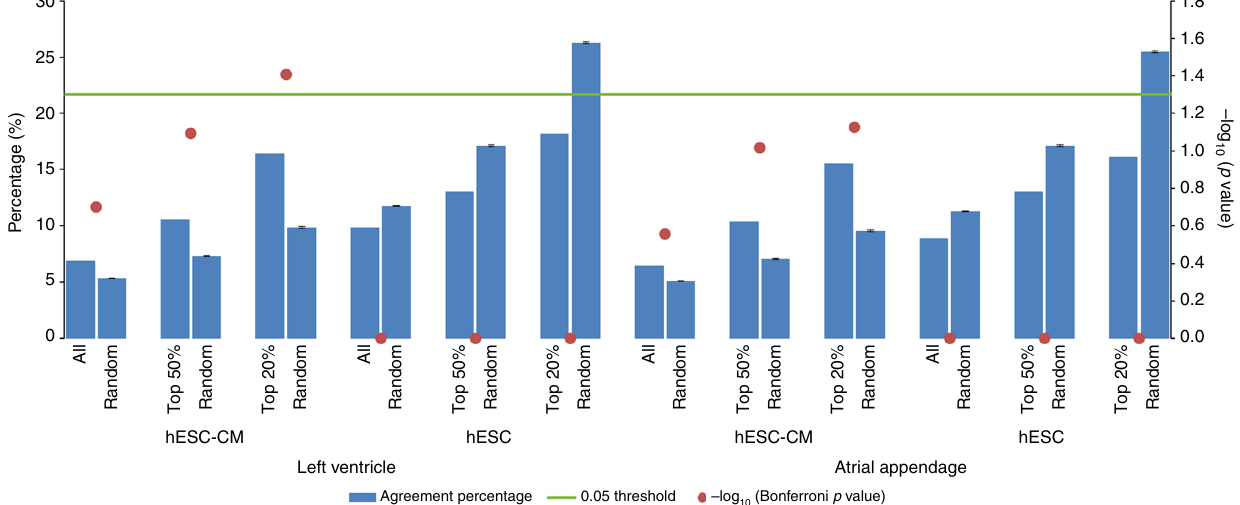
Fig. 3 Agreement percentages of eQTL – gene and PIR – gene pairs. Agreement percentages of eQTL – gene (GTEx) and PIR – gene pairs (either cPIRs or hESC PIRs), fi ltered to the top 20% and 50% of read counts, in the left ventricle and atrial appendage. Results obtained with randomised PIRs (1000 permutations) are shown as controls. The p values were generated from permutation tests performed to compare observed vs. randomised PIRs and corrected for multiple testing using Bonferroni